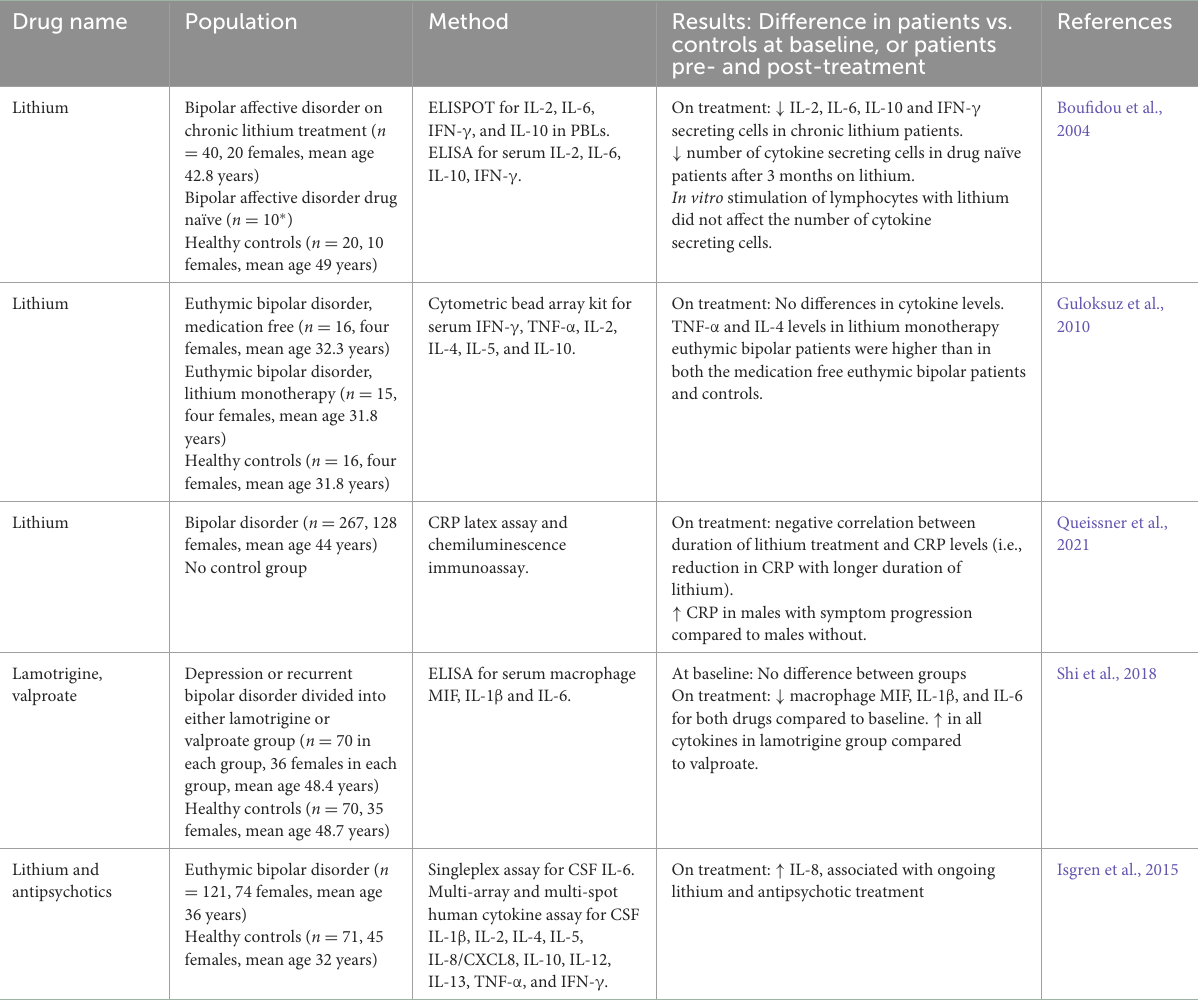
TABLE 4 Anti-inflammatory effects of mood stabilizers in human